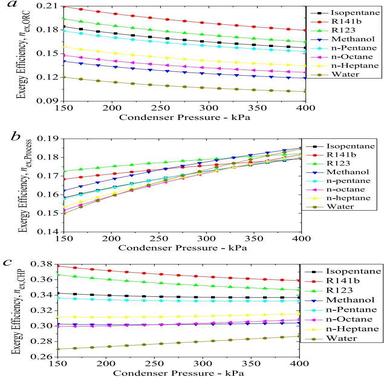
Effect of condenser pressure on exergy efficiencies in ORC (a) Process (b) CHP (c).